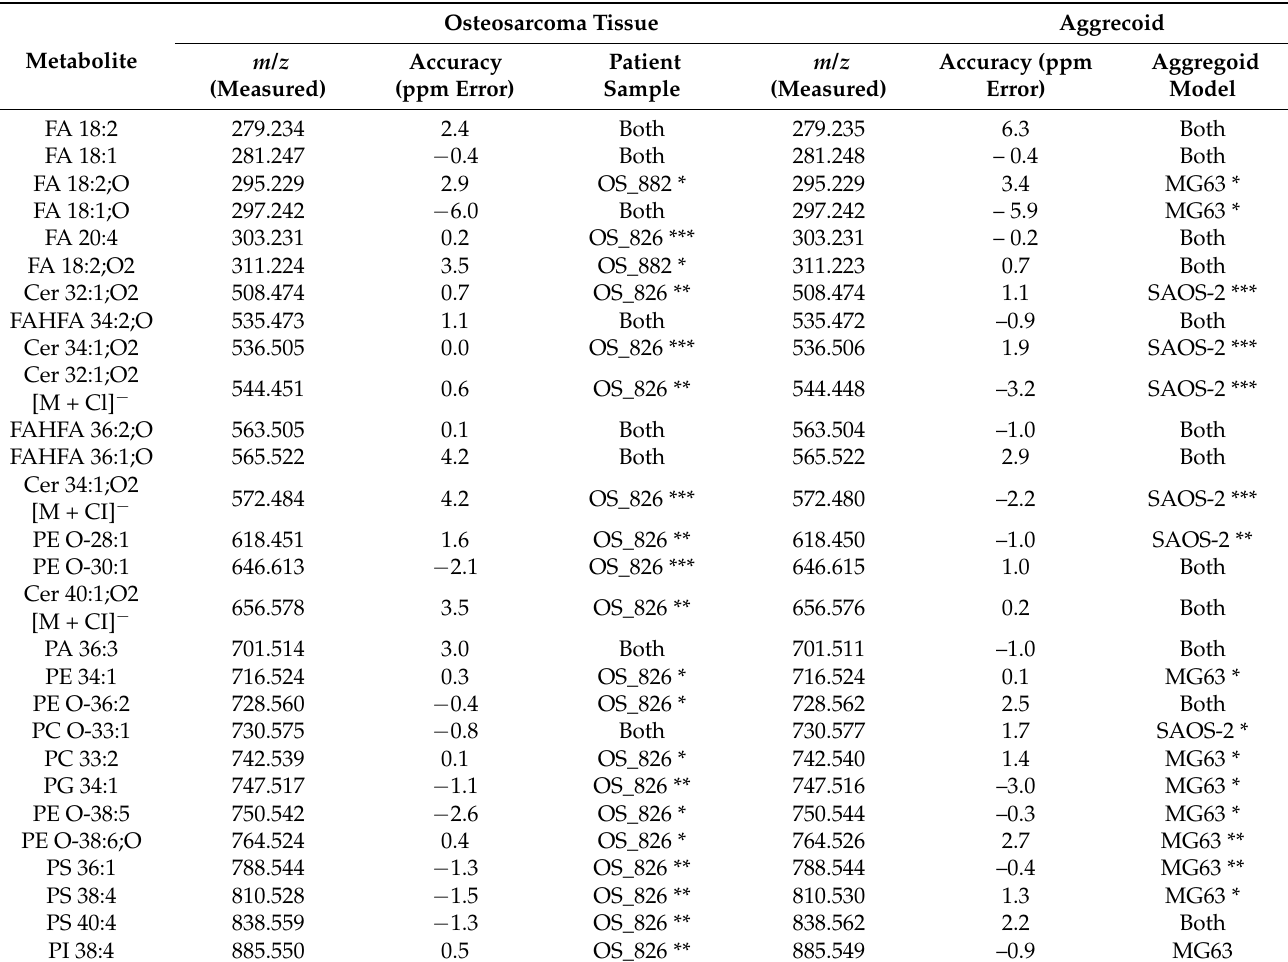
Table 2. Assignments and errors for metabolites detected in both the OS human tissue samples and OS aggregoid models, MG63 and SAOS-2. Metabolites were filtered by removal of isotope peaks and mass accuracy (<7 ppm). Significant metabolite detection between tumour models was determined by mean intensities. Data are mean ( n = 3), unpaired t test